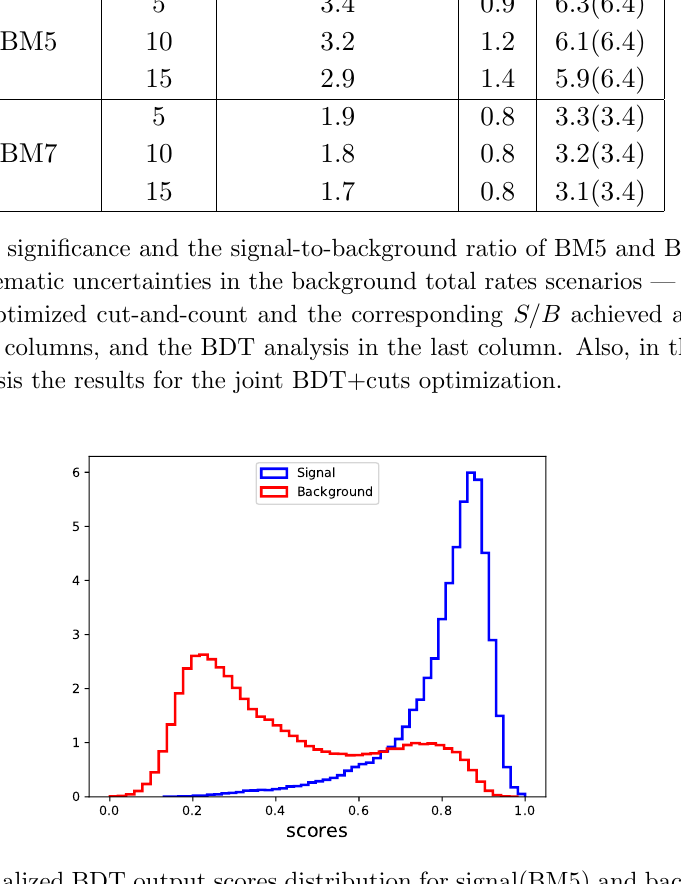
Figure 6 . The normalized BDT output scores distribution for signal(BM5) and background events after joint cuts and hyperparameters optimization. A (cid:12)nal selection is obtained by an additional cut on these